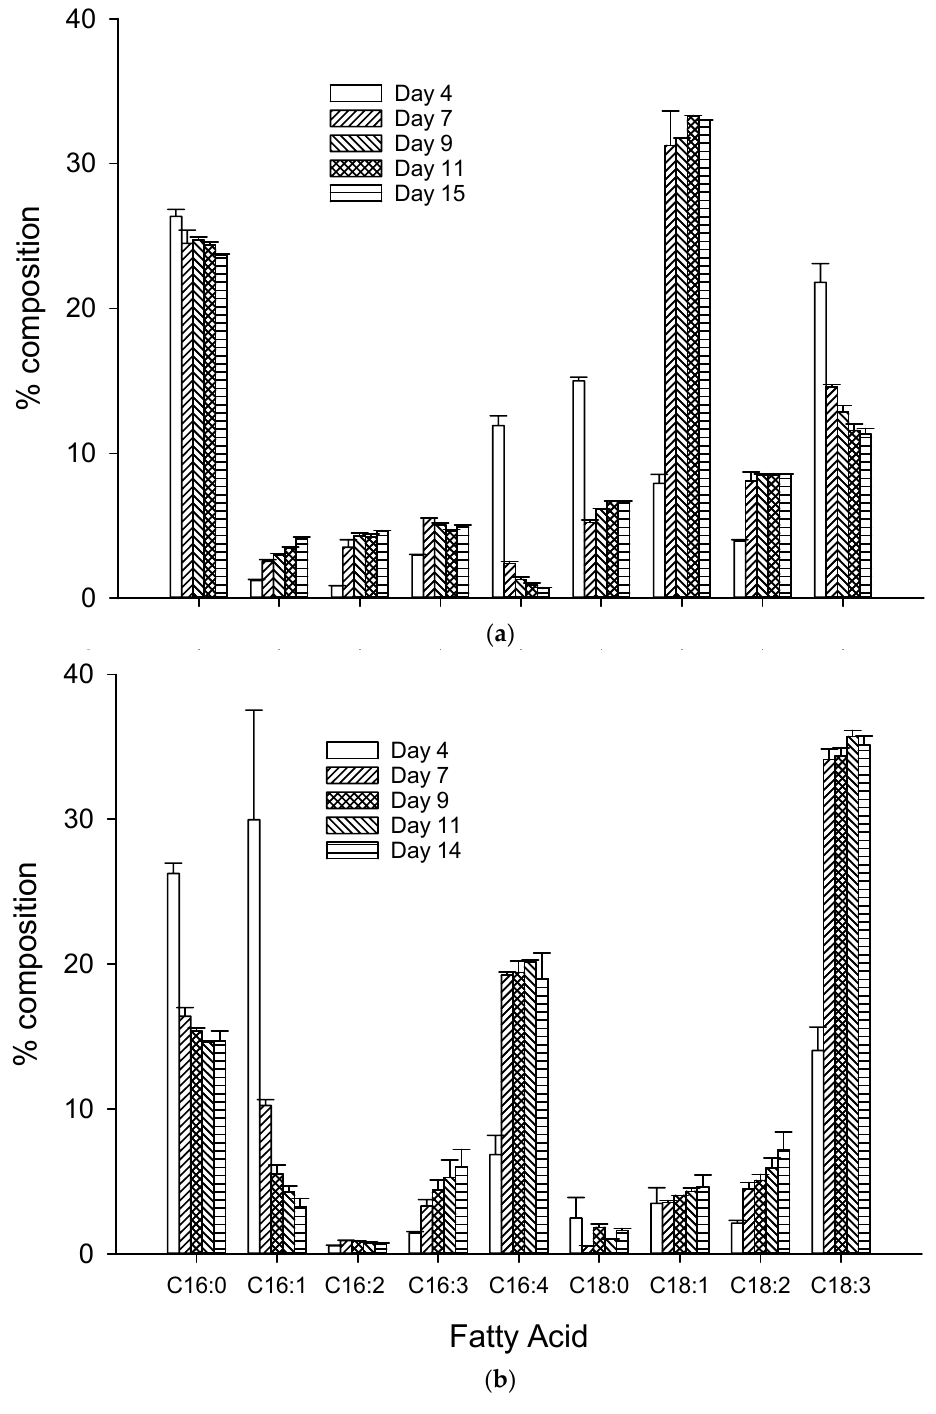
Figure 4. Fatty acid composition (% of total fatty acids) in Chlorella sp. in batch cultures containing either ( a ) LN media or ( b ) HN media (sampling day legend inset).